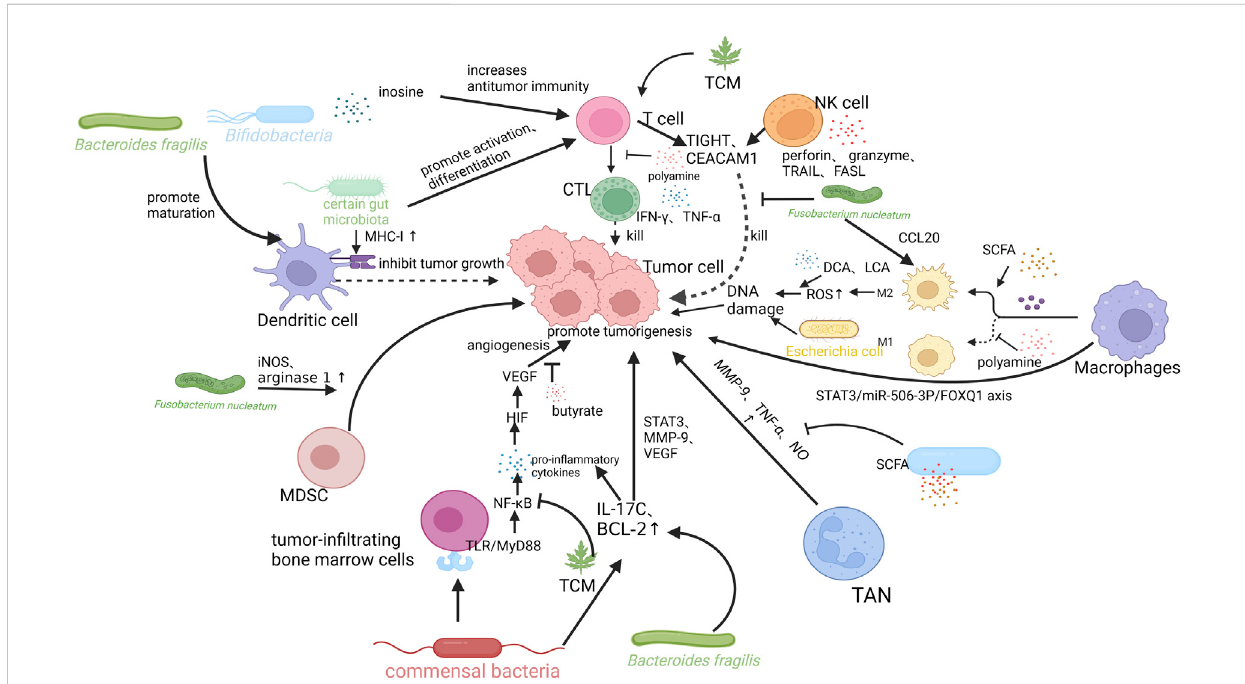
FIGURE 2 Mechanisms of intestinal fl ora and its metabolites, tumor microenvironment (TME), and traditional Chinese medicine (TCM) interactions. Bi fi dobacteria and Bacteroides fragiligis can promotethematuration ofDCsand promoteanti-tumorimmunity.Certaingut microbiota can promotethe expression ofMHC-I inDCs, promote Tcell differentiation into CTL, produce IFN- γ , TNF- α kill tumor cells. Fusobacterium nucleatum can recruit MDSCs in TME and increase the expression levels of arginase 1 (ARG1) and inducible nitric oxide synthase (iNOS) in these cells, which in turn inhibits the activity of T cells and promote intestinal tumorigenesis. Bacteroides fragilis also induces submucosal IL-17 expression and promotes IL-17-mediated colonic in fl ammation. SCFA can also exert anti-in fl ammatory effects by reducing the production of TNF- α and nitric oxide (NO), and inhibiting NF- κ B signaling.Itcanalsomediate antitumorimmunitybyincreasingthepolarizationofM2macrophages.M2macrophages causeDNAdamagebyproducing high levels of ROS, promoting tumor invasion and metastasis. Deoxycholic acid (DCA) and lithocholic acid (LCA) may promote CRC in this way. Fusobacterium nucleatum induces the expression of CCL20 and transforms macrophages to the M2 type. Tumor-associated macrophages (TAMs) can also induce EMT via STAT3/miR-506-3p/FOXQ1 axis to support the growth and metastasis of CRC. NK cells can trigger targeted cell death by releasing lysed particles, such as perforin and granzyme. They can also induce apoptosis and promote antitumor immunity by binding TNF-related apoptosis inducingligandandFasligandtoreceptorsoncolorectaltumorcells. Fusobacteriumnucleatum bindstoandactivatesTIGITandCEACAM1expressedby T and NK cells, directly blocking their ability to kill tumor cells and suppressing anti-tumor immunity. TCM can exert antitumor effects by in fl uencing the activation of T cells, inhibiting in fl ammatory pathways, and regulating the composition of intestinal fl ora. Created with